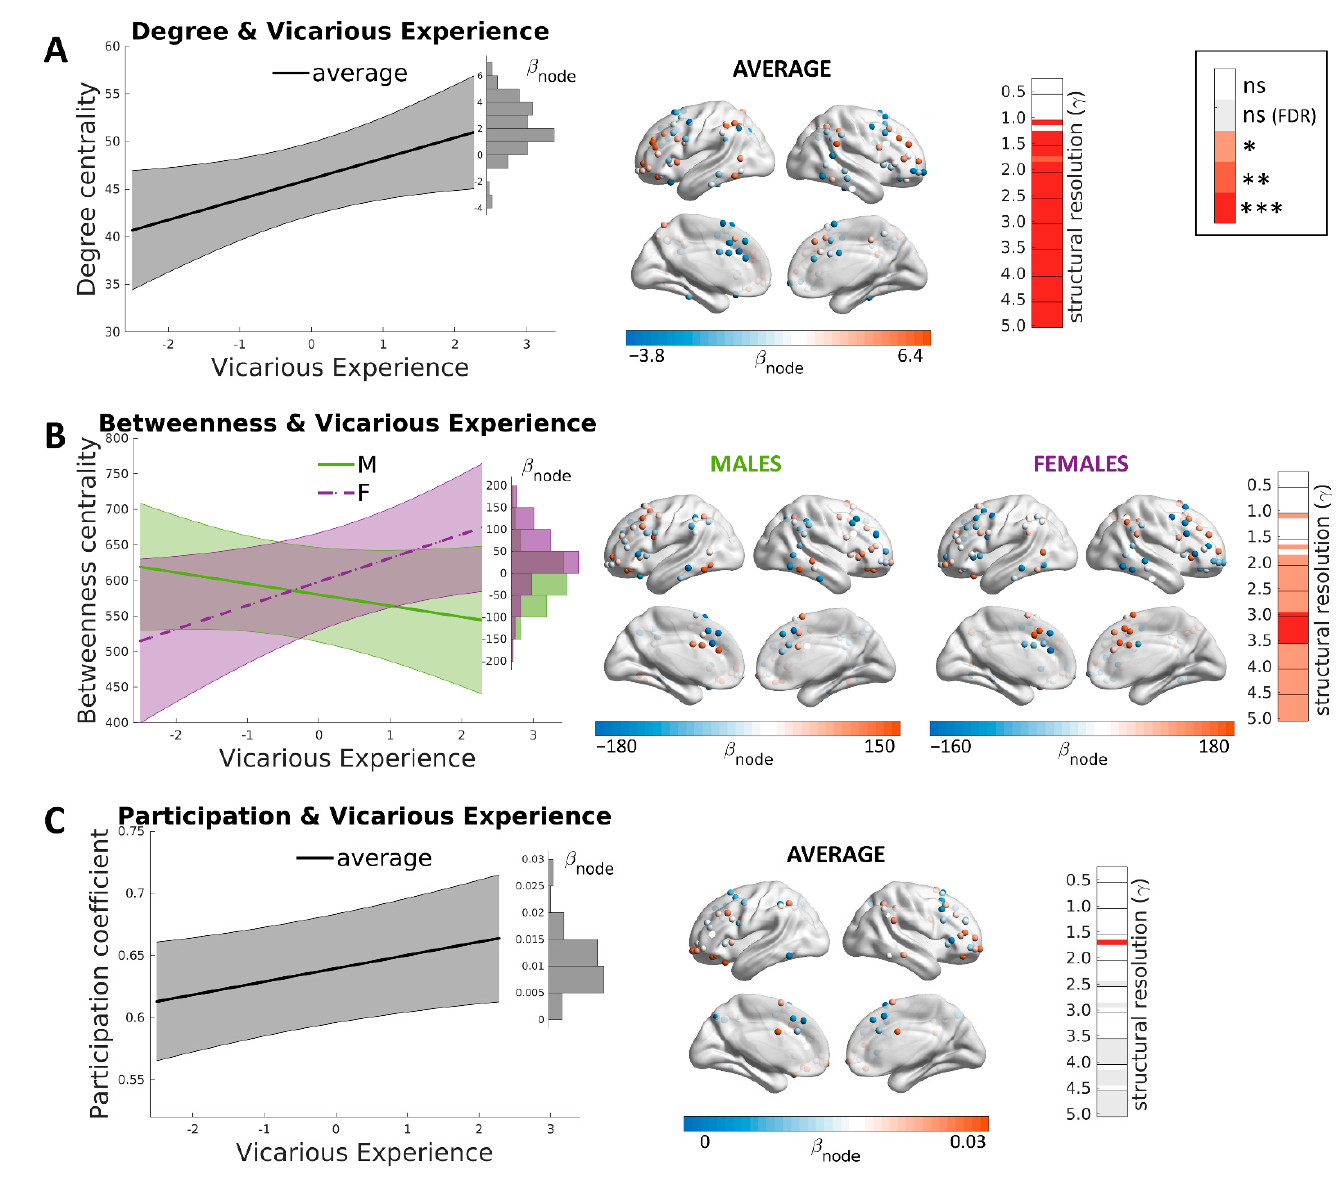
Figure 3. Brain correlates of Vicarious Experience. ( A ) The association between degree centrality of the fronto-parietal module and vicarious experience did not depend on sex, as shown in the prediction plot on the left. The highest contributors to the association were in the dorsolateral prefrontal cortex. The result was consistent with every value of structural resolution in which the fronto-parietal module was detected ( γ > 1.0). ( B ) Betweenness centrality in the fronto-parietal module and vicarious understanding were positively associated in females and slightly negatively associated in males. The highest associations were in mid-cingulate regions. The result was consistent with medium and high structural resolutions ( γ > 1.5). ( C ) The association with the participation coefficient of fronto-parietal nodes was not dependent on sex. Such a result was significant after multiple comparisons only with a specific value of structural resolution ( γ > 1.7). Legend for significance with respect to structural resolutions: white = non-significant; gray = non-significant after correction for multiple comparisons; light red * = p < 0.05; medium red ** = p < 0.01; dark red *** = p < 0.005.